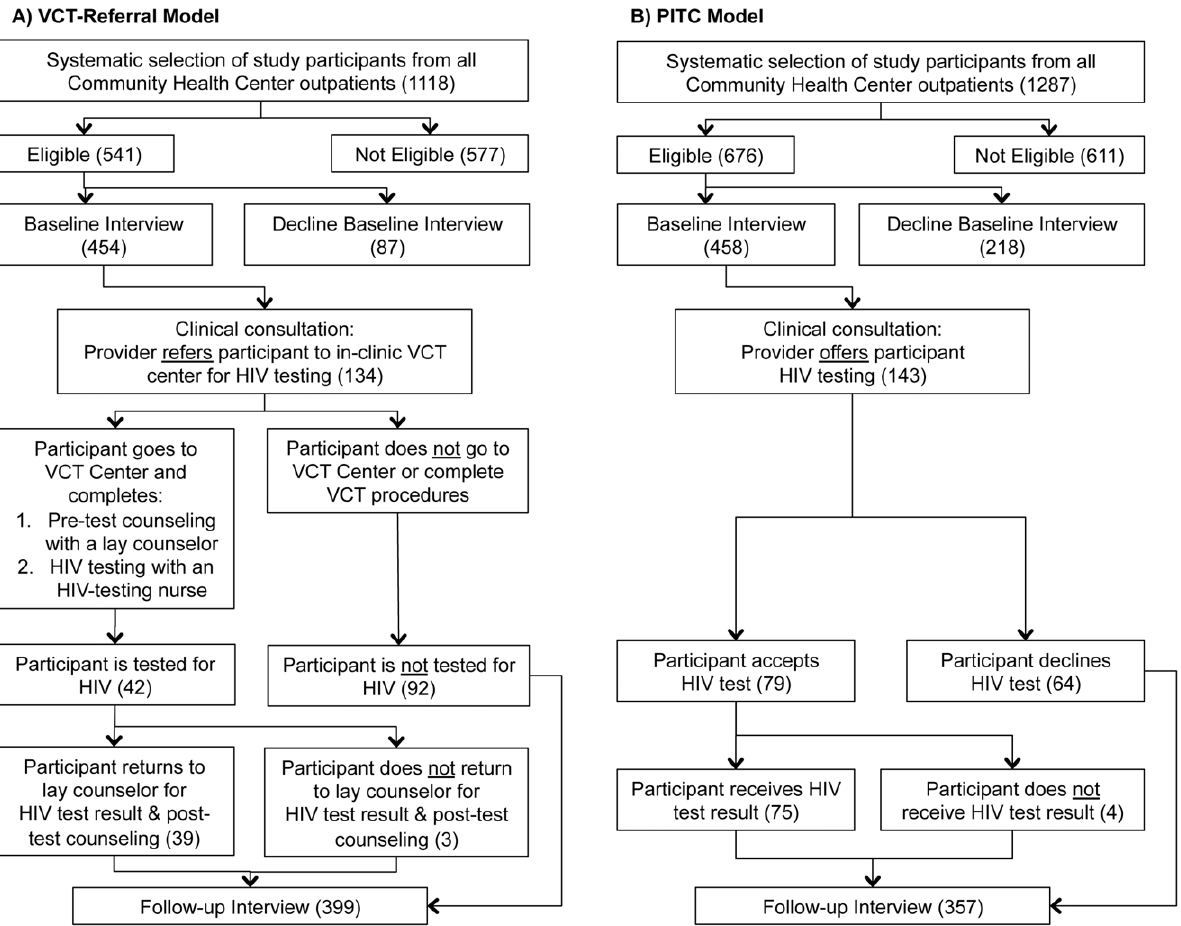
Figure 1. Participant sample sizes are given in parentheses. Participant enrollment algorithm and HIV testing procedures under the VCT referral (A), and PITC models (B).